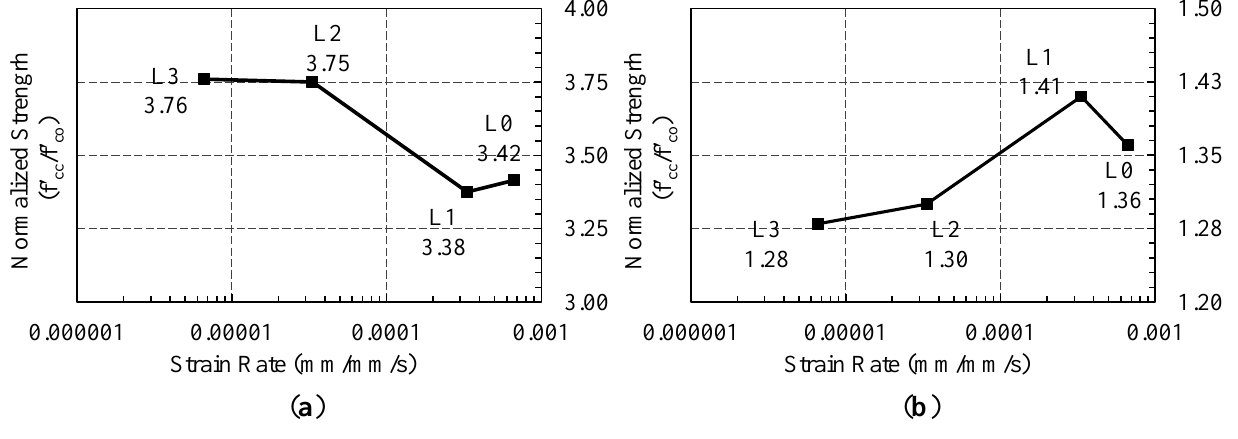
Figure 4. The variation of strength enhancement. ( a ) Low strength. ( b ) Medium